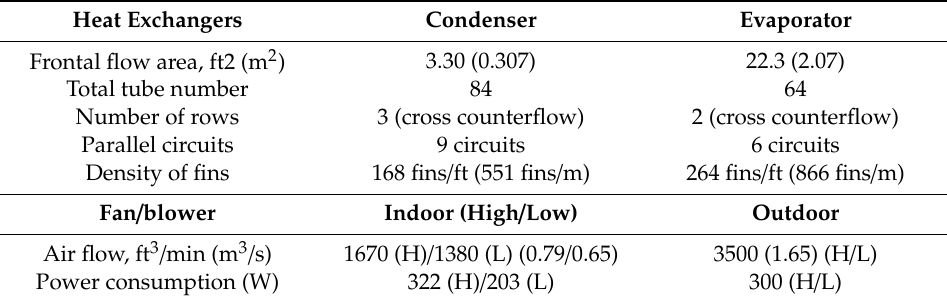
Table 3. Dimensions of indoor and outdoor fin-and-tube heat exchangers.